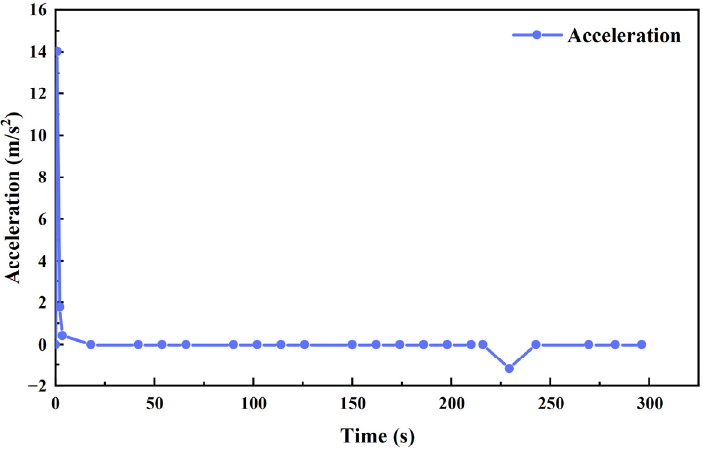
Figure 8. Variation in the downward acceleration of the plunger.